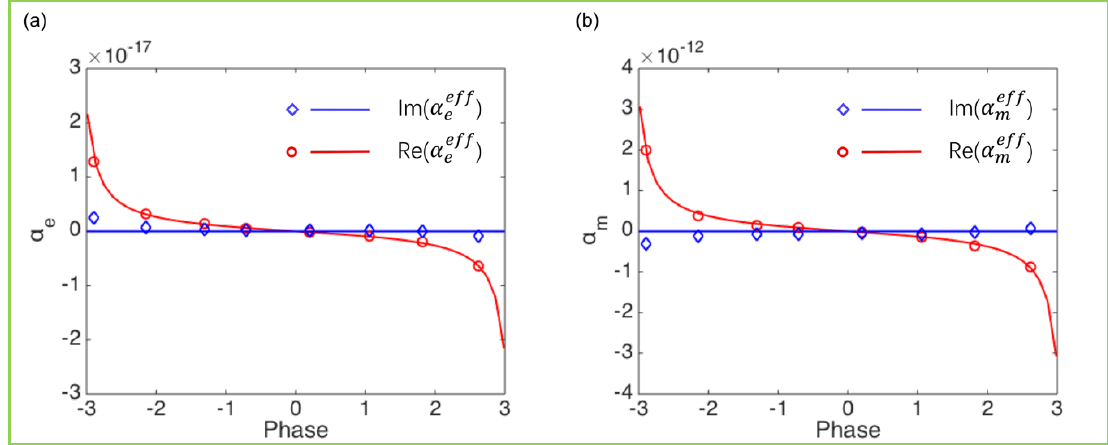
Figure 3. Effective ( a ) electric and ( b ) magnetic polarizabilities α eeff / α meff of the selected eight meta- Figure 3. E ff ective ( a ) electric and ( b ) magnetic polarizabilities α e ff e / α e ff m of the selected eight meta-atoms. atoms. The solid line is the ideal electromagnetic polarizabilities of Huygens meta-atoms. The solid line is the ideal electromagnetic polarizabilities of Huygens